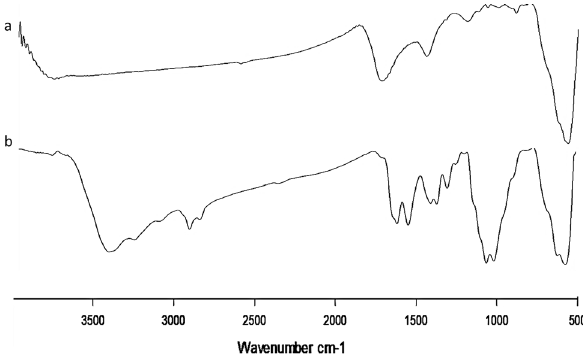
Fig. 2 FTIR analysis of a SPIONs, b chitosan-coated